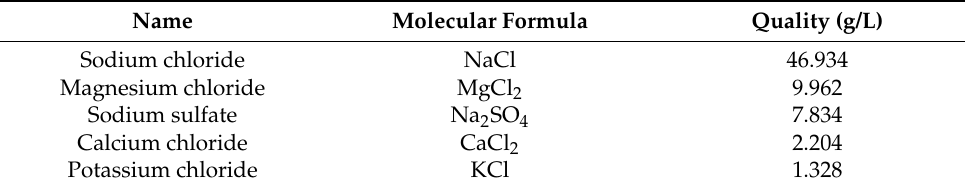
Table 4. Chemical composition of artificial seawater.